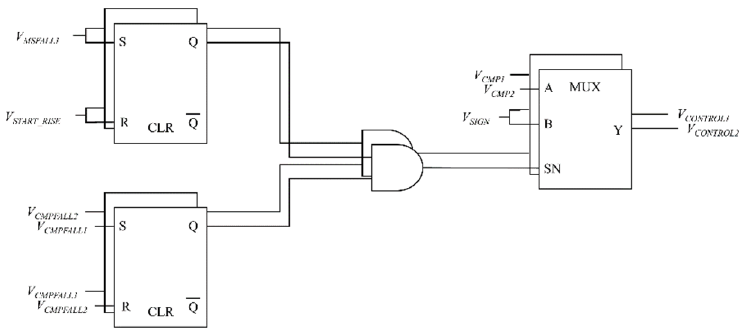
Figure 11. The schematic of the state-switching circuit.